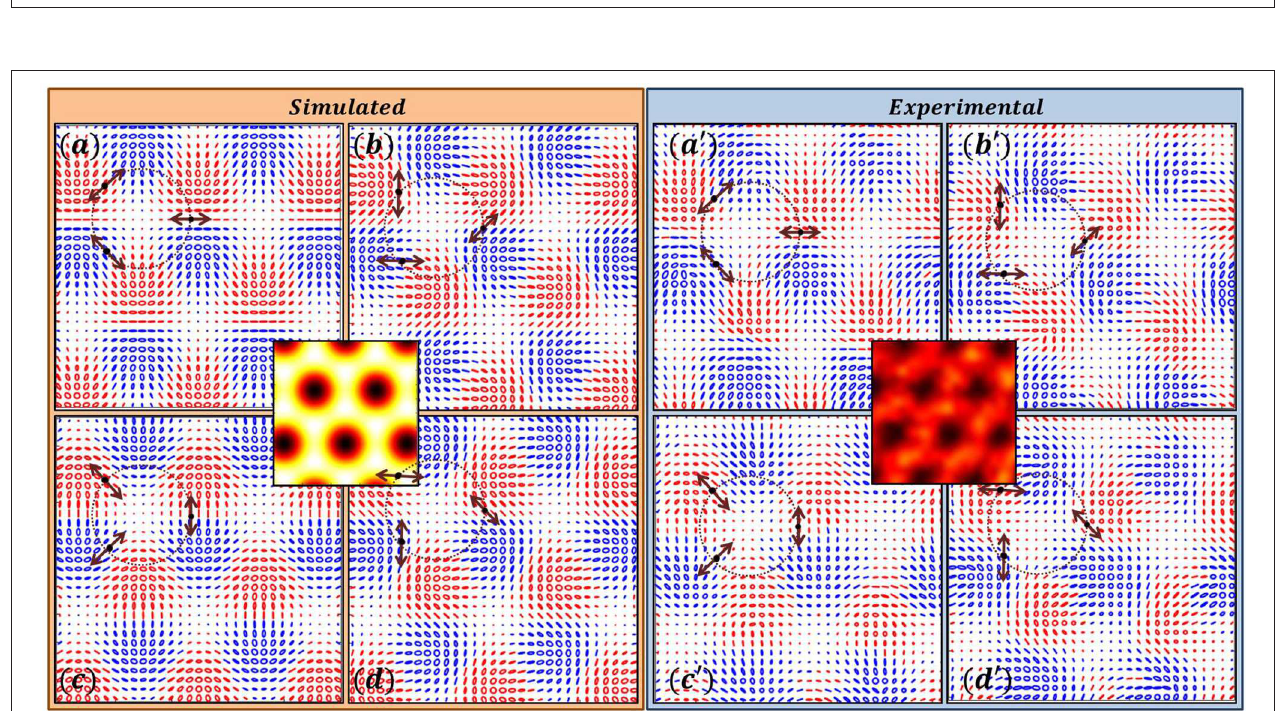
FIGURE 4 | Three Beam Interference producing lattice of lemons. The SOPs of the three plane waves are derived from a V-point with η = − 1. Simulated results in (a–d) and experimental results in (a ′ –d ′ ) .